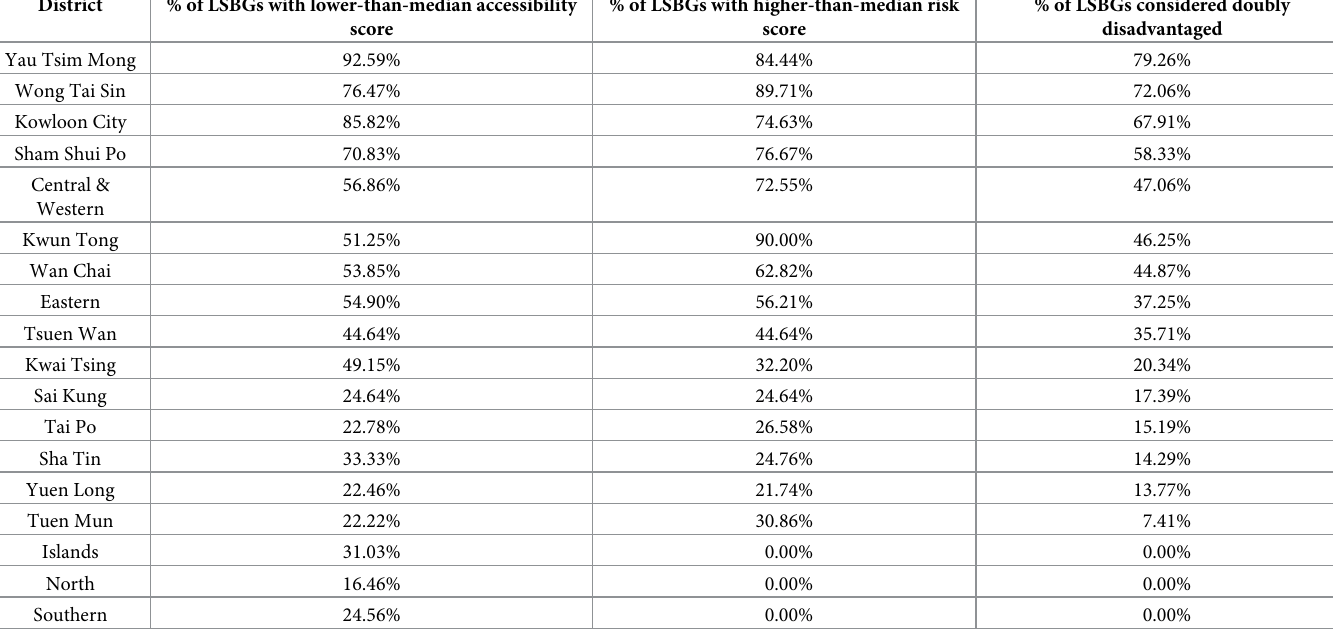
Table 2. Percentage of LSBGs considered disadvantaged in terms of green & blue spaces accessibility and COVID-19 infection risk. District